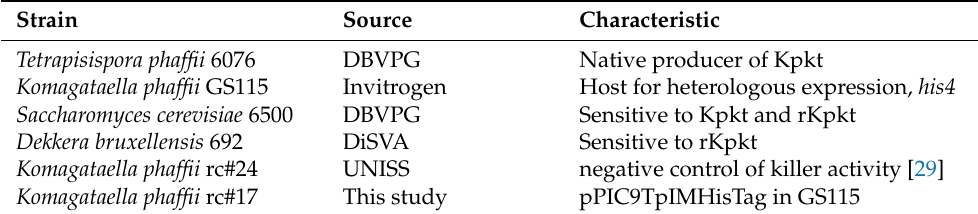
Table 1. Microbial strains utilized in the present work. Strain Source